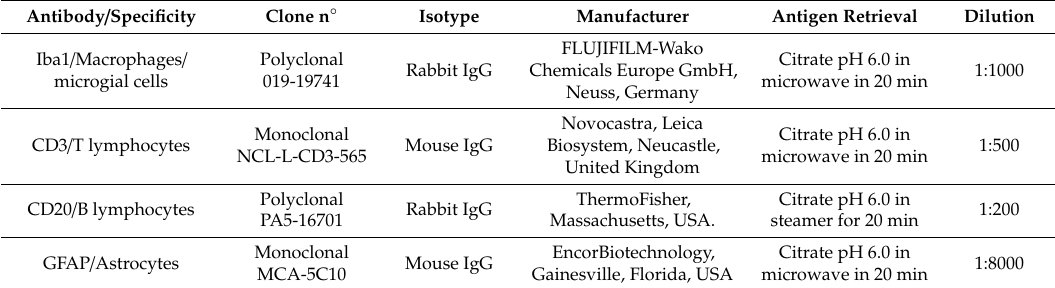
Table 1. Immunohistochemical protocols used for cellular type